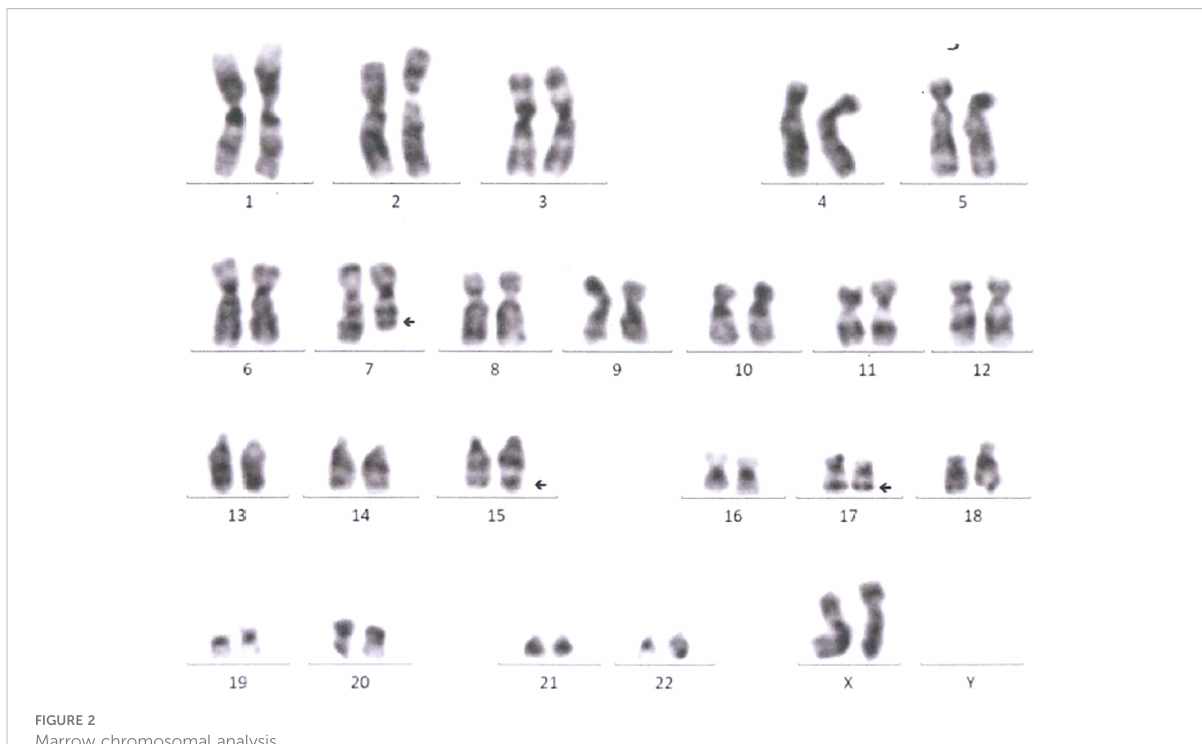
FIGURE 2 Marrow chromosomal